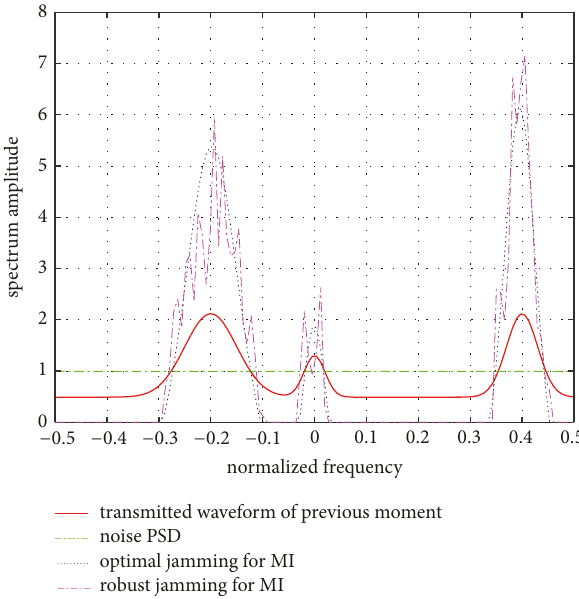
Figure 7: Jamming results for multiple targets.